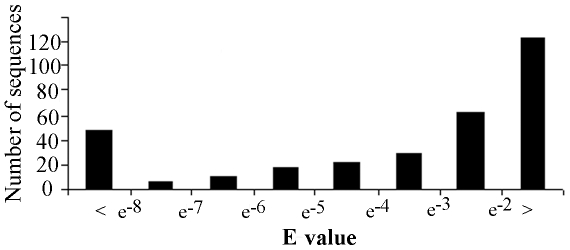
The distribution of the seabass miRNA precursor candidates in various E value intervals as identified by the BLASTn program showing conservation with known pre-miRNAs.Conservation of the 322 unique sequences that cloned from the seabass cDNA library with known pre-miRNAs was identified by the BLASTn program (E value). The most common conservation intervals were <e−2 (123 sequences), between e−2 and e−3 (63 sequences) and followed by <e−8 (48 sequences).